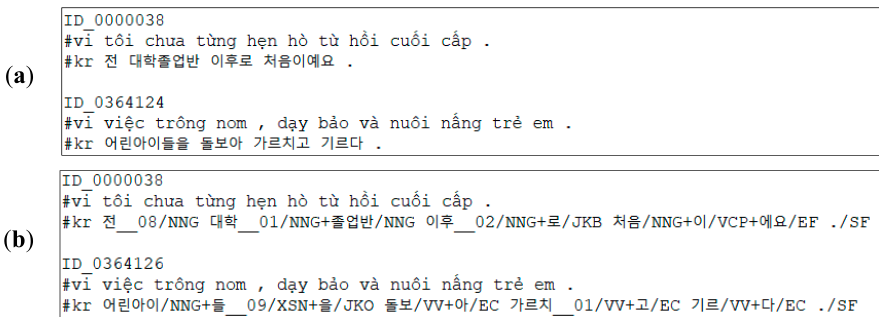
Figure 8. A part of the Korean-Vietnamese parallel corpus. ( a ) The parallel corpus in its initial form.